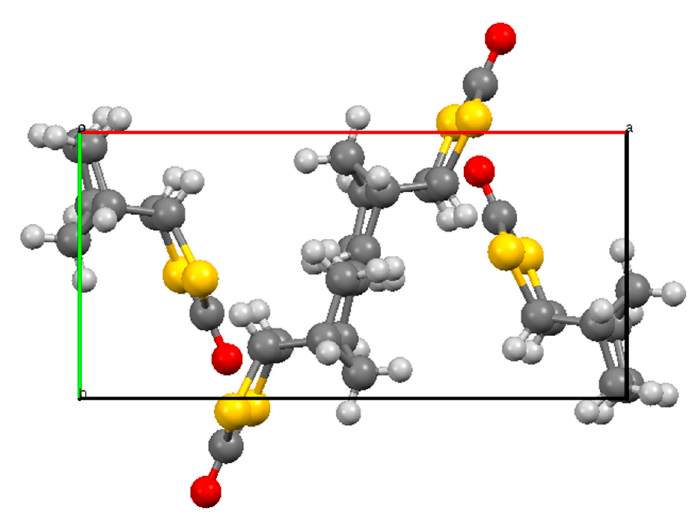
Figure 2. Unit cell of 1 viewed along the c -axis showing the four molecules present.